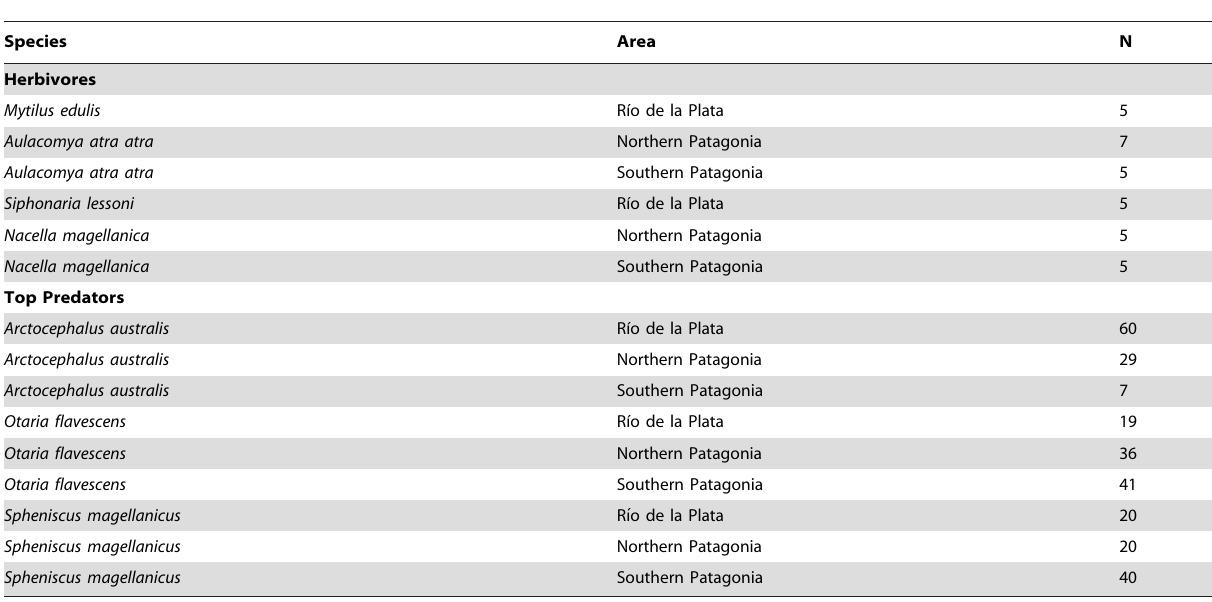
Table 1. Samples used to reconstruct the modern food